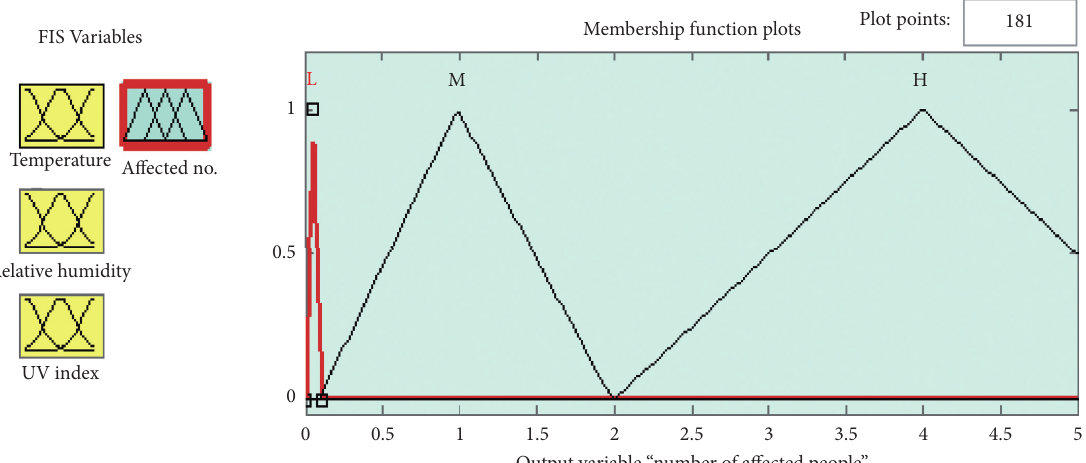
Figure 3: Number of affected people as the output variable.